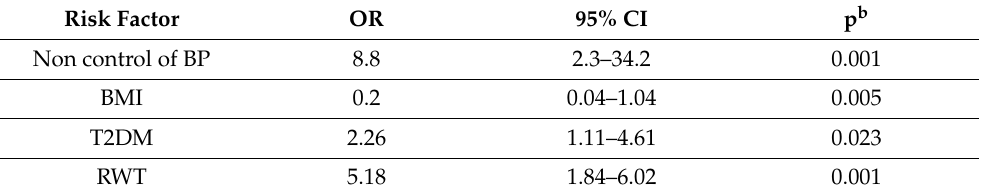
Table 5. Independent factors of lower GLS risk resulting from logistic regression in hypertensive patients. Adjusted odds ratio (OR) and associated 95% confidence interval